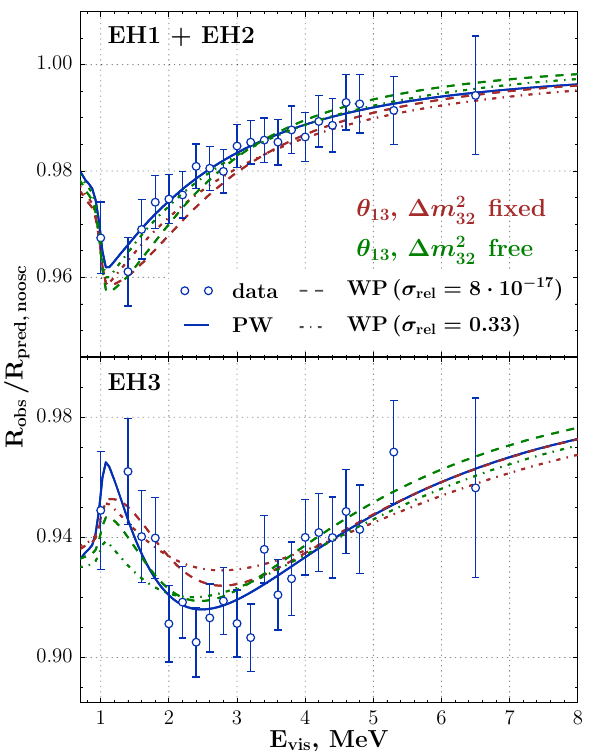
Fig. 1 Ratios of the observed to expected numbers of IBD events in the absence of oscillation as a function of reconstructed visible energy E vis . The data are grouped by near (EH1 + EH2) and far (EH3) halls, displayed in the upper and in the bottom panels respectively, with the error bars representing the statistical uncertainties. Superimposed solid lines are ratios assuming neutrino oscillations within the plane wave model (PW) with the best-fit values of sin 2 2 θ 13 and Δ m 2 obtained 32 with the plane wave model. The ratios using the wave-packet model (WP) assume σ rel = 0 . 33 ( dashed line ) and σ rel = 8 × 10 − 17 ( dot – dashed line ), as two examples. The green lines correspond to the wave packet model ratios assuming the best-fit values of sin 2 2 θ 13 and Δ m 2 32 obtained with the plane wave model and thus, inconsistent with the data by about five standard deviations. The red lines correspond to the wave packet model ratios assuming the best-fit values of sin 2 2 θ 13 and Δ m 2 obtained within the wave packet model, yielding a much better 32 agreement with the data. All ratios enter the region below 2 m e , which corresponds to the IBD threshold, because of detector response effects likeenergyreconstructionandabsorptionintheinneracrylicvessel(see details in Refs.